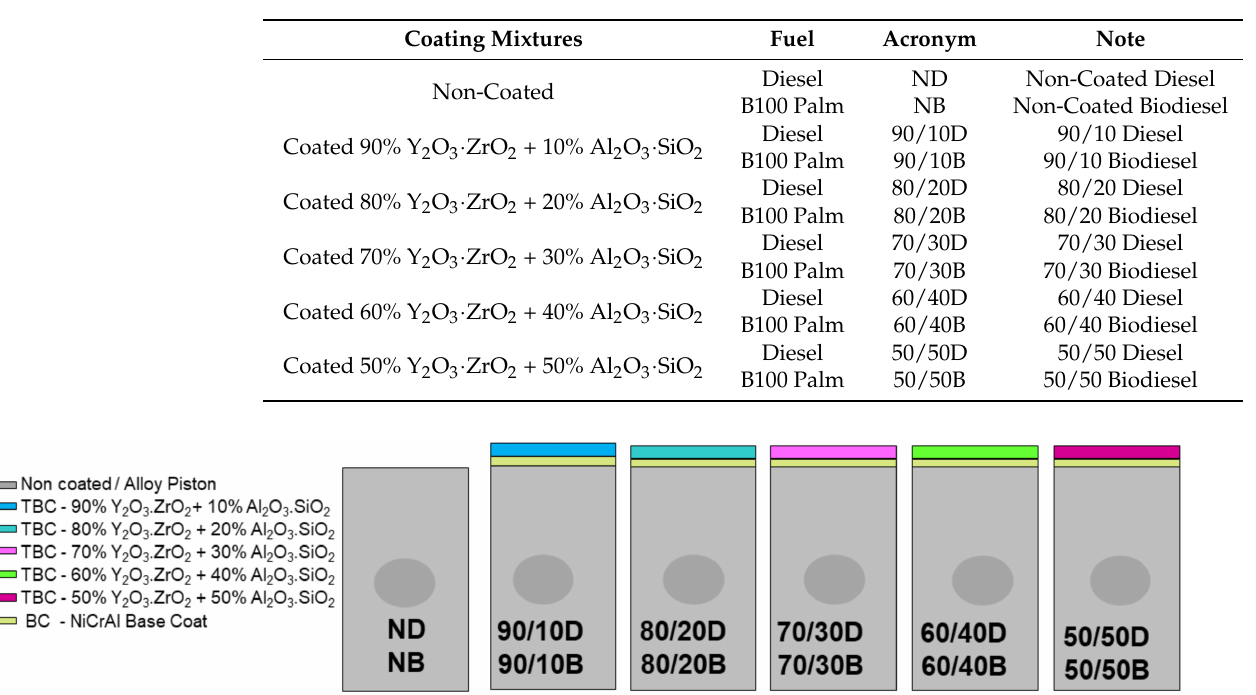
Table 3. List of TBC mixture.